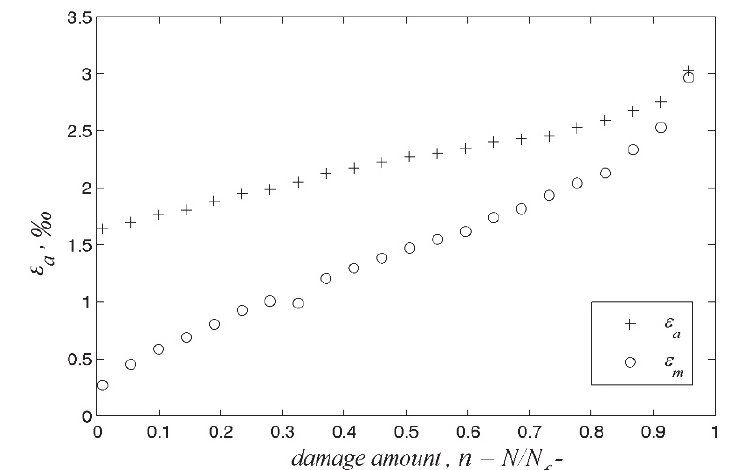
Figure 8: Amplitude and mean value of strain during fatigue test, where: ε z – strain amplitude.